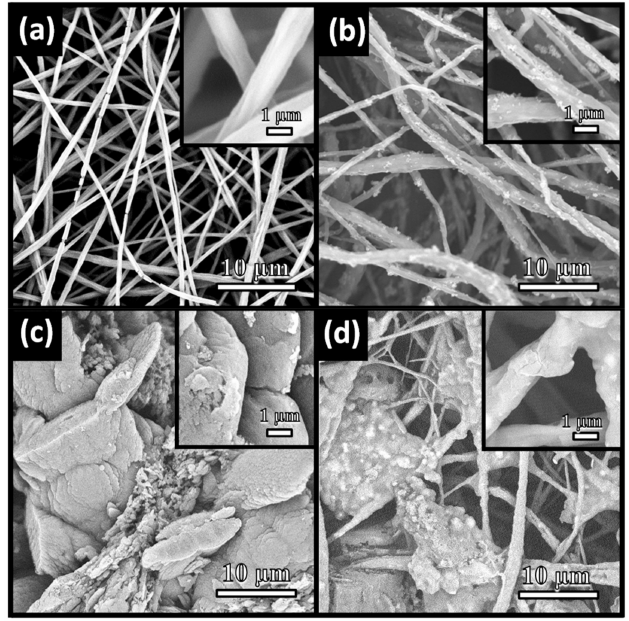
Figure 3. SEM images of ( a ) TBOT / PVDF fibers, ( b ) TiO 2 / PVDF fibers, ( c ) g-C 3 N 4 and ( d ) TPCN2.